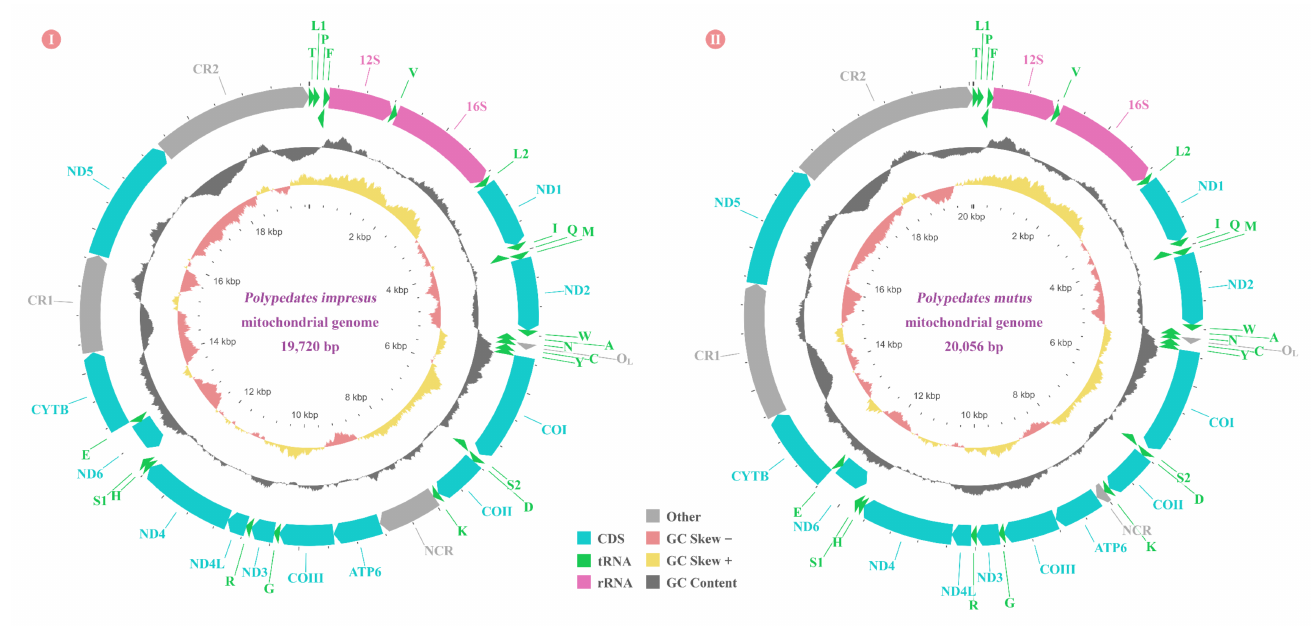
Figure 1. Mitogenome map of Polypedates impresus ( I ) and Polypedates mutus ( II ). Genes encoded on the heavy strand (H-strand) are plotted on the outer circle with clockwise arrows, and genes encoded on the light strand (L-strand) are plotted on the inner circle with counterclockwise arrows. Arrows represent the transcription orientation. Abbreviations: ATP6 , adenosine triphosphate (ATP) synthase subunits 6; COI – III , cytochrome c oxidase subunits 1 – 3; CYTB , cytochrome b; ND1 – 6 and ND4L , nicotinamide adenine dinucleotide hydrogen ( NADH ) dehydrogenase subunits 1 – 6 and 4L; 12S rRNA and 16S rRNA , small and large ribosomal RNA (rRNA) subunits; O L , origin of replication on the L-strand; NCR, noncoding region; CR, control region. Transfer RNA (tRNA) genes are indicated with their one-letter amino acid code of the corresponding amino acid. The length of features was drawn to match their actual nucleotide proportion in the